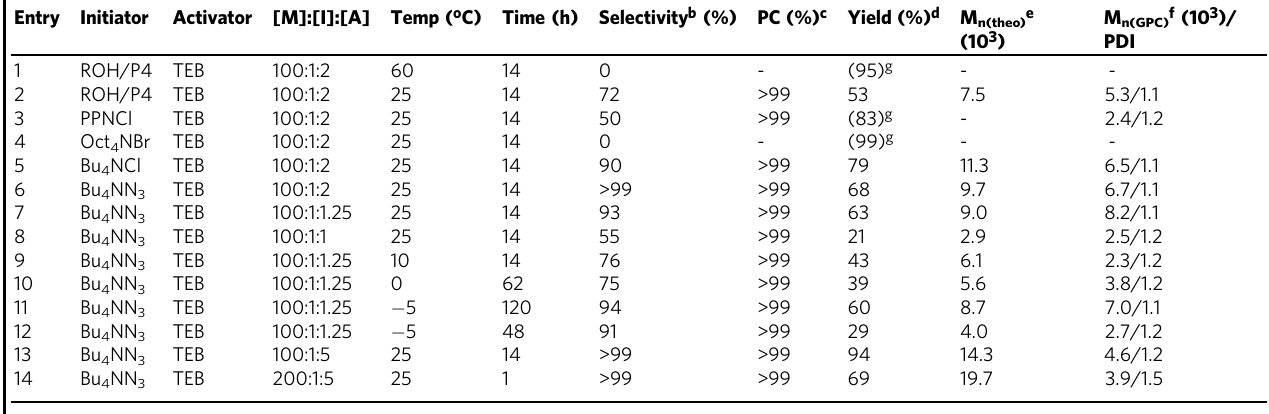
Entry Initiator Activator [M]:[I]:[A] Temp ( o C) Time (h) Selectivity b (%) PC (%) c Yield (%) d M n(theo) e